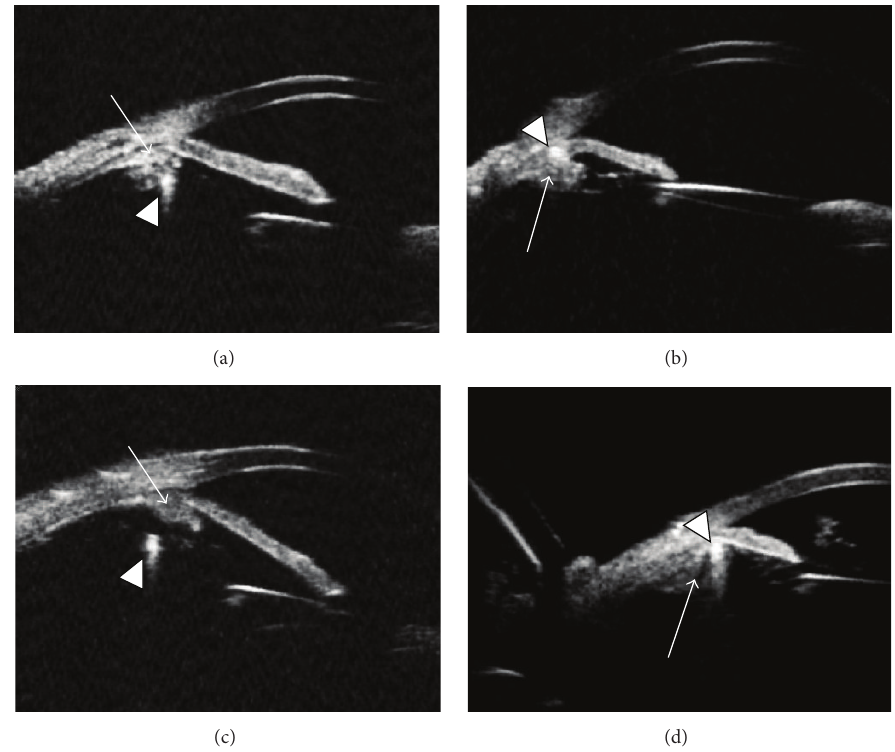
Figure 2: Ultrasound biomicroscopy of eyes submitted to intraocular lens fixation using UBM images. Arrows show the ciliary body, and arrow heads show the haptic. (a) Ab externo , haptic placed in the ciliary body; (b) ab interno , haptic in the sulcus; (c) ab interno , haptic posterior to the ciliary body; (d) haptic in the